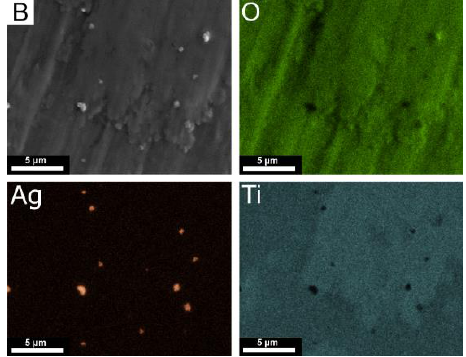
Figure 6. Elemental distribution map and chemical composition from a chosen region, Specimen B